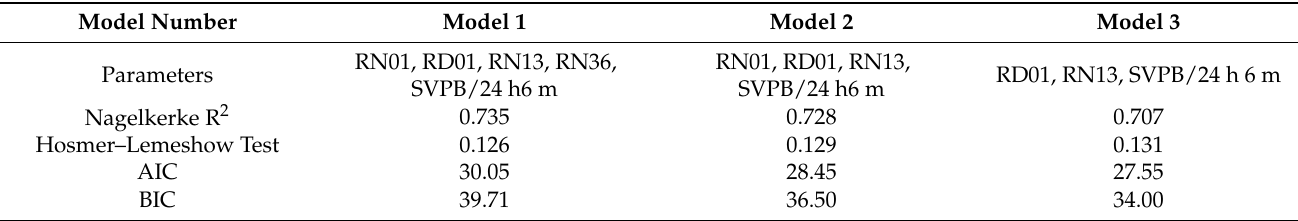
Table A3. Multivariate models of AFR between 6–12 months.